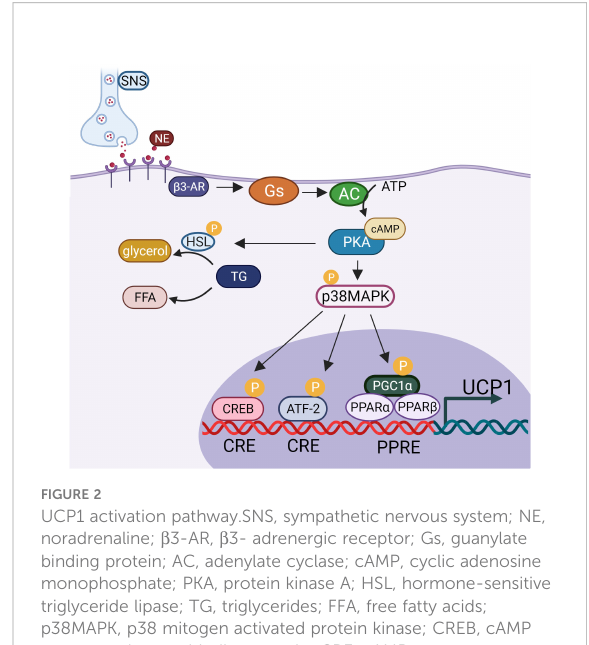
FIGURE 2 UCP1 activation pathway.SNS, sympathetic nervous system; NE, noradrenaline; b 3-AR, b 3- adrenergic receptor; Gs, guanylate binding protein; AC, adenylate cyclase; cAMP, cyclic adenosine monophosphate; PKA, protein kinase A; HSL, hormone-sensitive triglyceride lipase; TG, triglycerides; FFA, free fatty acids; p38MAPK, p38 mitogen activated protein kinase; CREB, cAMP response element binding protein; CRE, cAMP response element; PGC1- a , PPAR g coactivator-1 a ; ATF-2, activating transcription factor- 2; PPAR, proliferator-activated receptor; UCP1, uncoupling